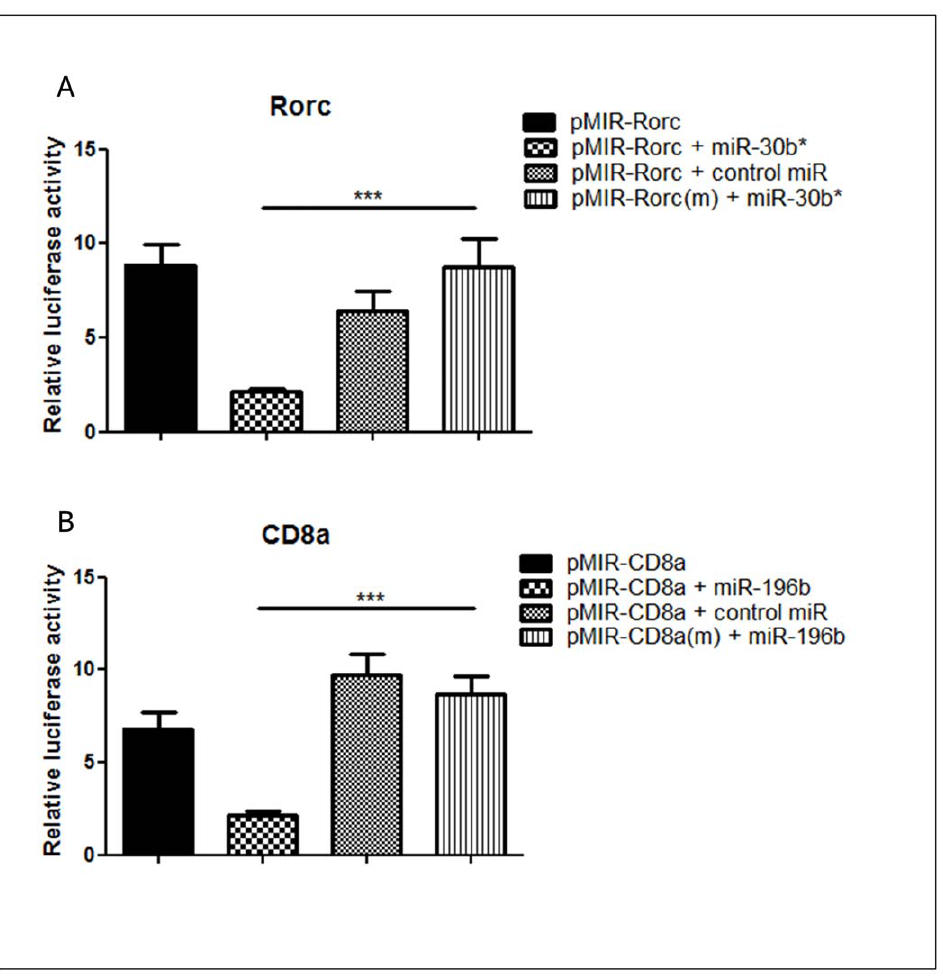
Figure 11. Luciferase reporter gene assay. pMIR-Rorc and pMIR-Rorc(m) 3 9 UTR luciferase plasmid were co-transfected with control or miR-30b* mimic (A), and pMIR-CD8a and pMIR-CD8a(m) with control or miR-196b (B) into HEK293 cells. Luciferase activity was evaluated at 24 h post transfections. Data are presented as means standard error of mean (SEM). The differences were evaluated by a one-way ANOVA followed by Bonferroni’s test. ** *P , 0.001 was considered statistically significant when the wild-type pMIR was compared to the mutant mismatch sequence in the presence of the respective miRNA mimic.